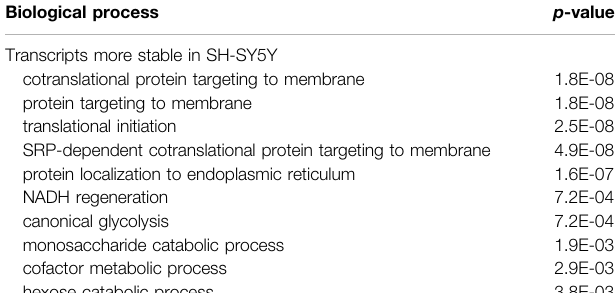
TABLE 1 | Top biological processes enriched for transcripts with differential stability in SH-SY5Y cells versus HEK293T cells. Biological process p